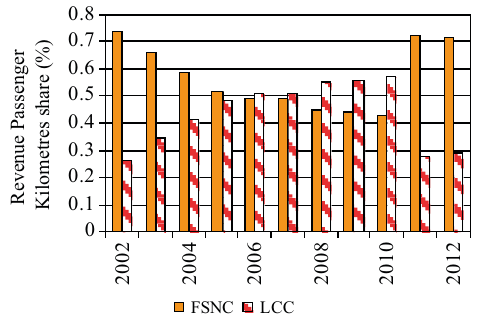
Fig. 4. Full service network and lower cost carrier annual revenue passenger kilometres (RPKs) market share: 2002–2013 (Bureau… 2014); Qantas Airways 2009, 2013; Tiger Airways (various), Virgin Australia (various))